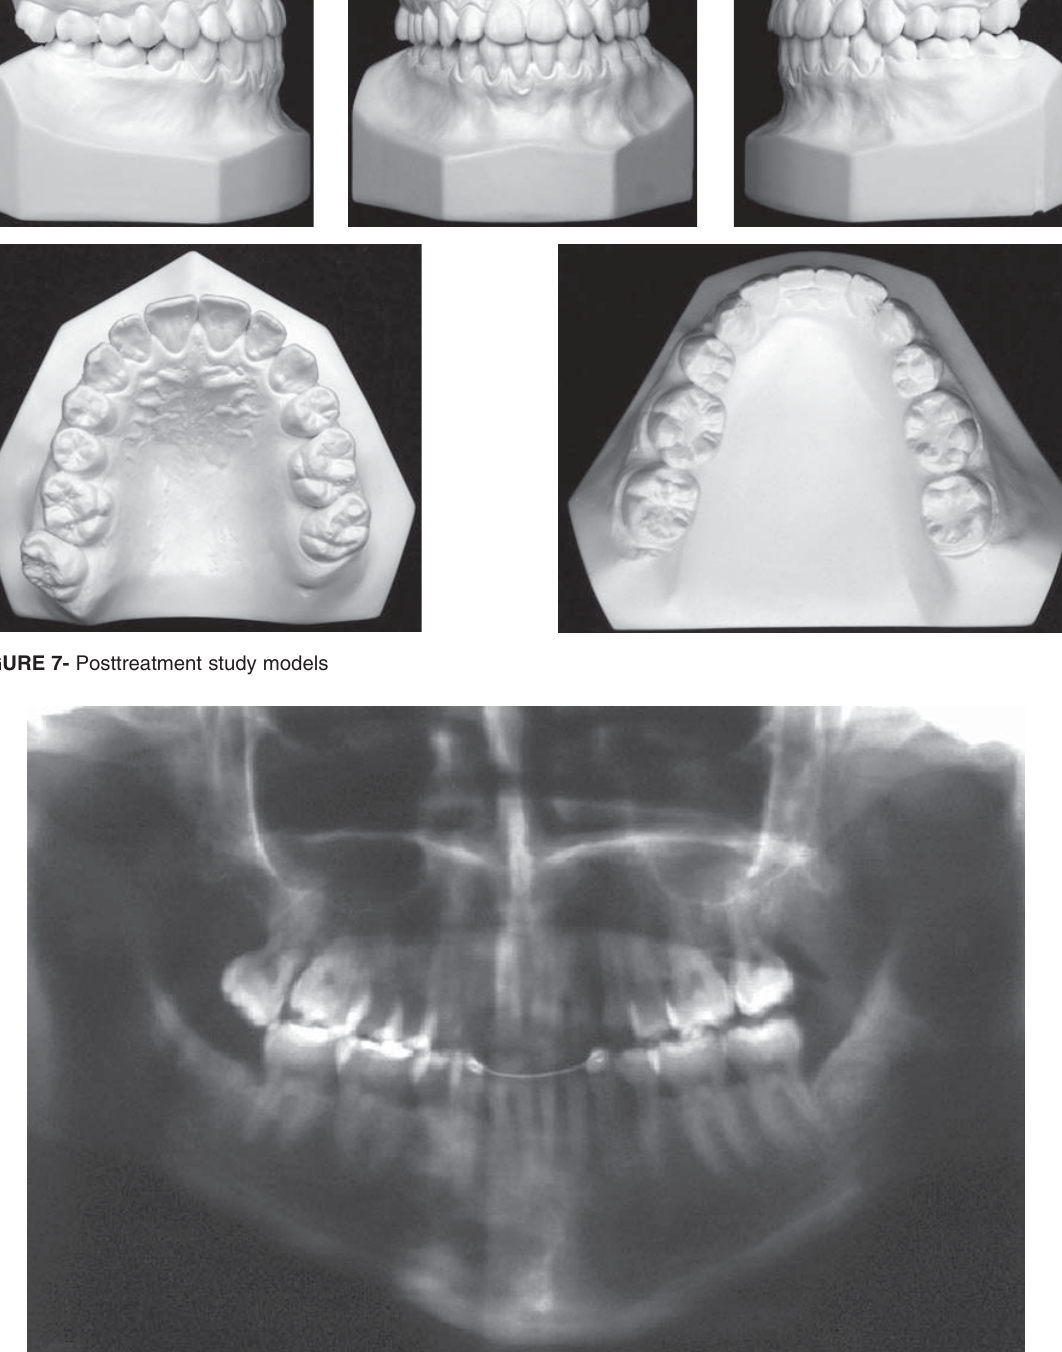
FIGURE 8- Posttreatment cephalometric radiograph